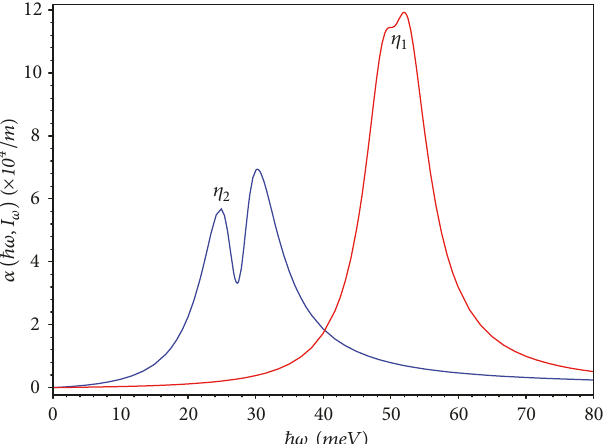
Figure 1: Dependence of the (𝑙 = 1) absorption coefficient, involving the ground state, on the incident photon energy for a CQW of radius 𝑅 = 100 ˚A. The two graphs correspond to an ICSW (𝜂